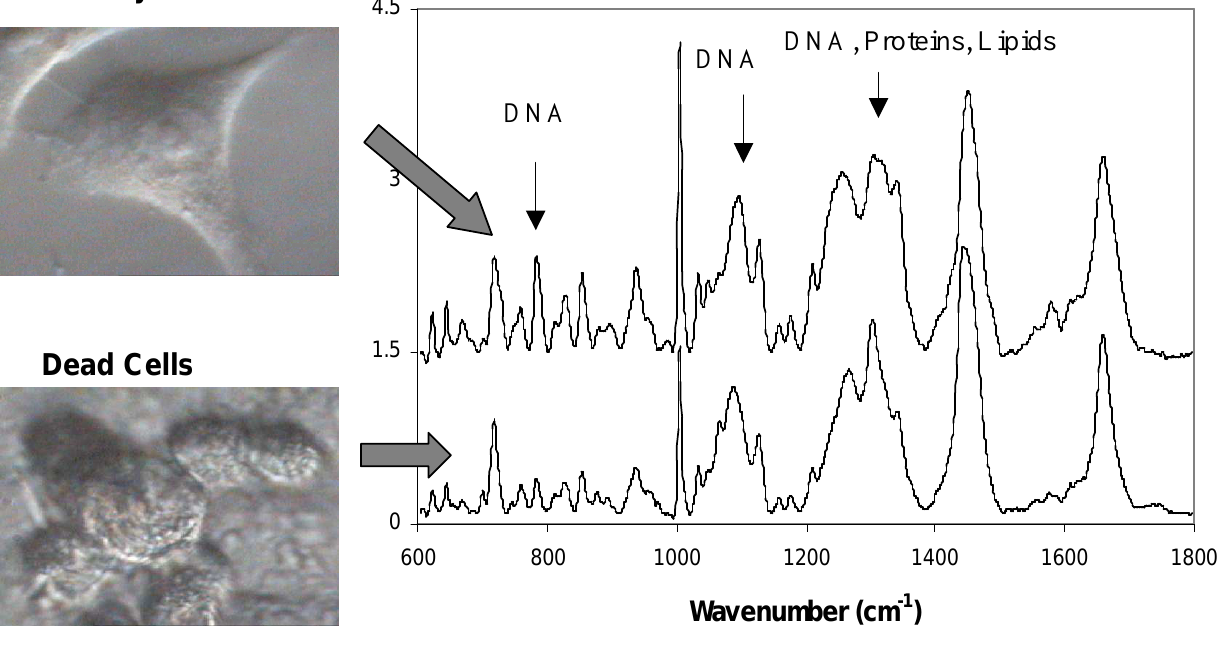
Figure 3 . Comparison between Raman spectra of healthy and dead cells. Significant differences are observed related to DNA, proteins and